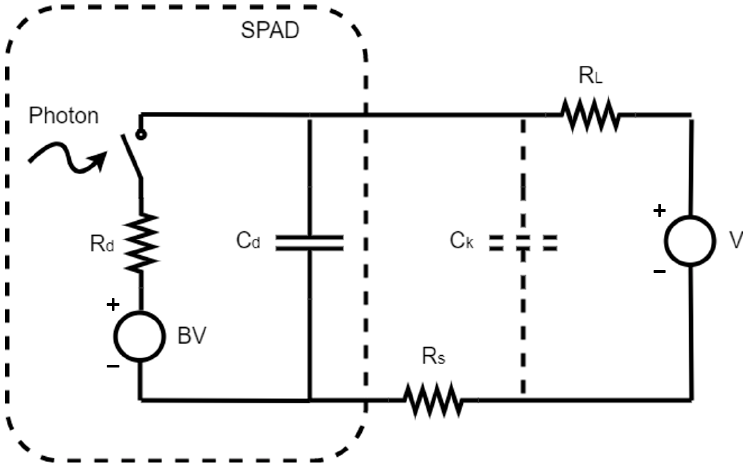
Figure 9. Simple SPAD circuit model (do tt ed box) with passive quench and reset circuit.